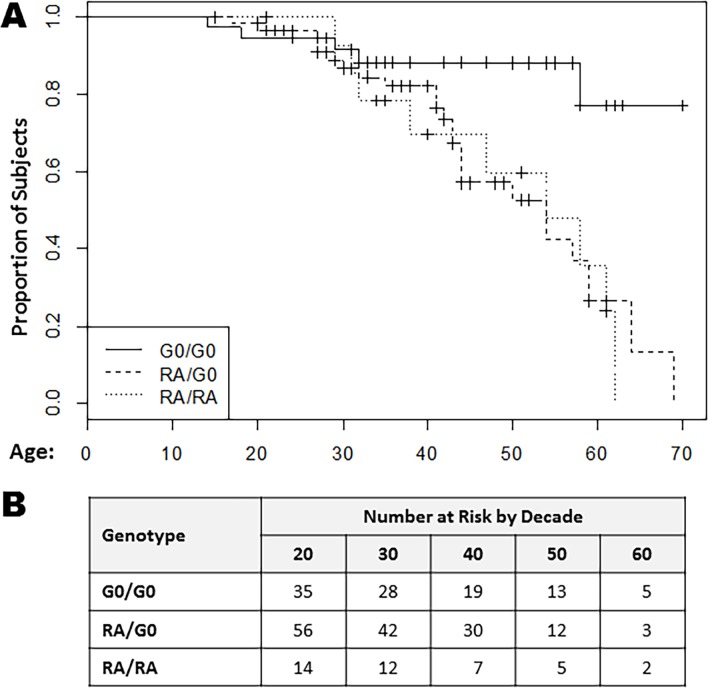
Time to atherosclerotic event analysis across APOL1 genotype.A) Time-to-event analysis for symptomatic atherosclerotic CVD as represented by Kaplan Meier Curves. The Y axis represents proportion of individuals free of the outcome, and the X axis represents subject age. Individuals were censored at latest age of follow up or death. B) The number of individuals present at each decade time point. In the 0-risk-allele group, 5/38 individuals met the outcome compared to 17/60 in the 1-risk-allele group and 8/15 in the 2-risk-allele group. Using the Log-Rank test, the proportion of subjects free from the endpoint was higher in the 0-risk-allele group compared to the 1- and 2-risk-allele groups (χ2 = 6.5; p = 0.04). Hazard Ratios (HR): for zero risk alleles vs one risk allele, HR = 4.2, 95% CI 1.6–11.0, p = 0.003; for zero risk alleles vs two risk alleles, HR = 4.6, 95% CI 1.5–13.8, p = 0.006.